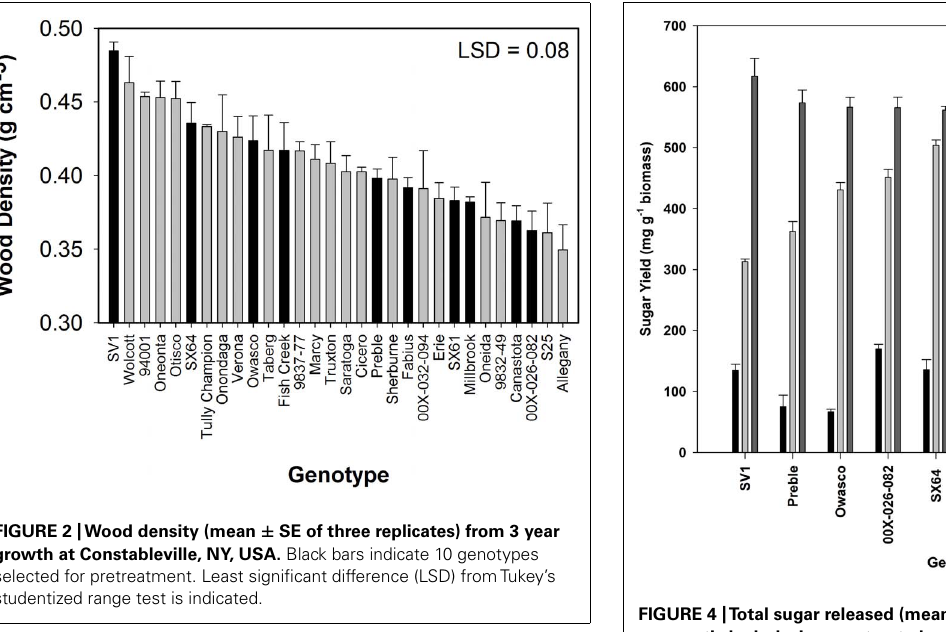
FIGURE 4 |Total sugar released (mean ± SE of three replicates) after enzymatic hydrolysis on untreated and hot-water pretreated biomass.